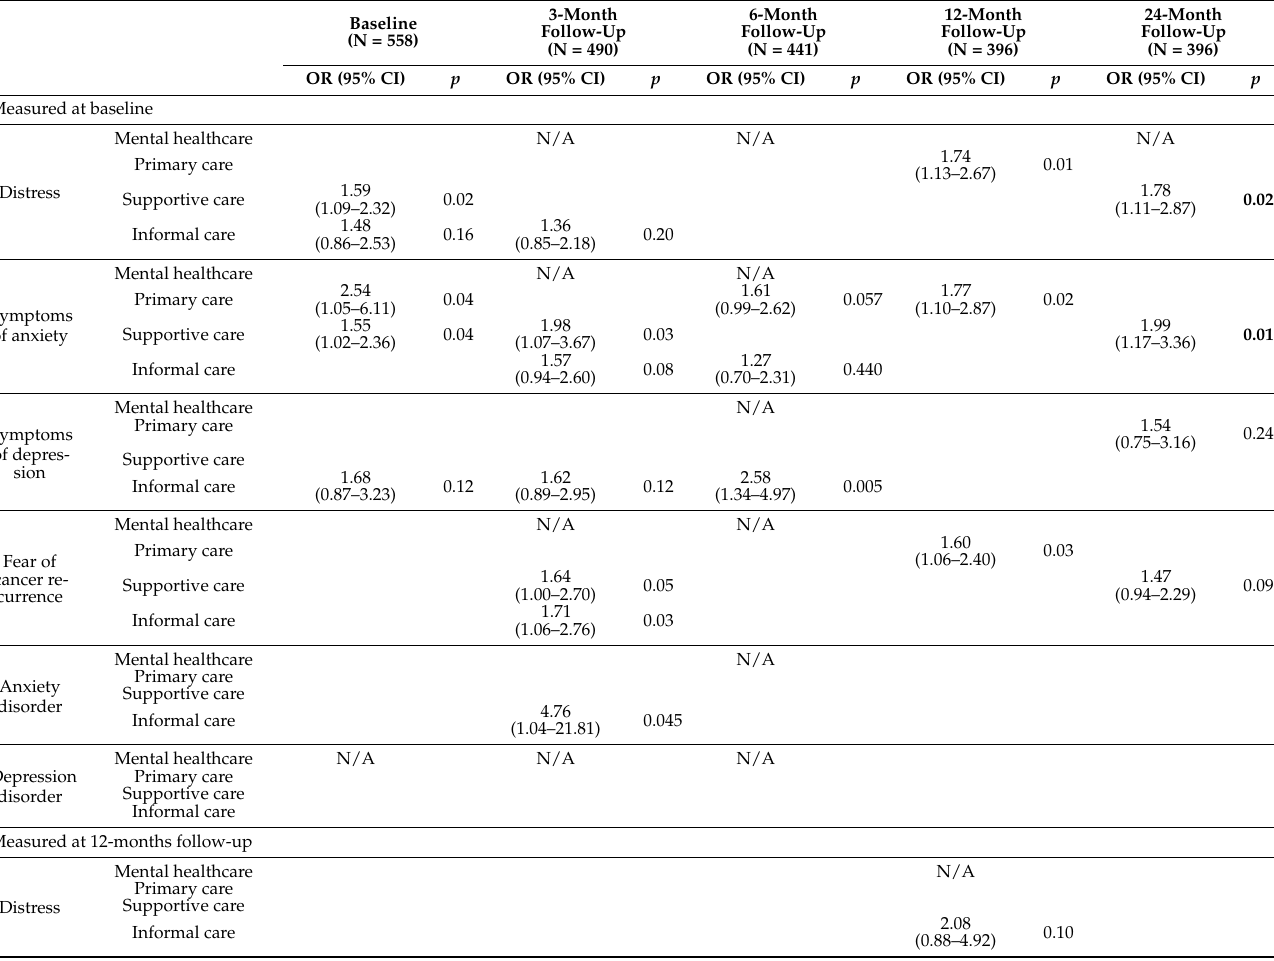
Table 3. Multivariate analyses testing associations between psychological problems at baseline and 12- months follow-up and use of care at baseline, 3-,6-,12-, and 24-month